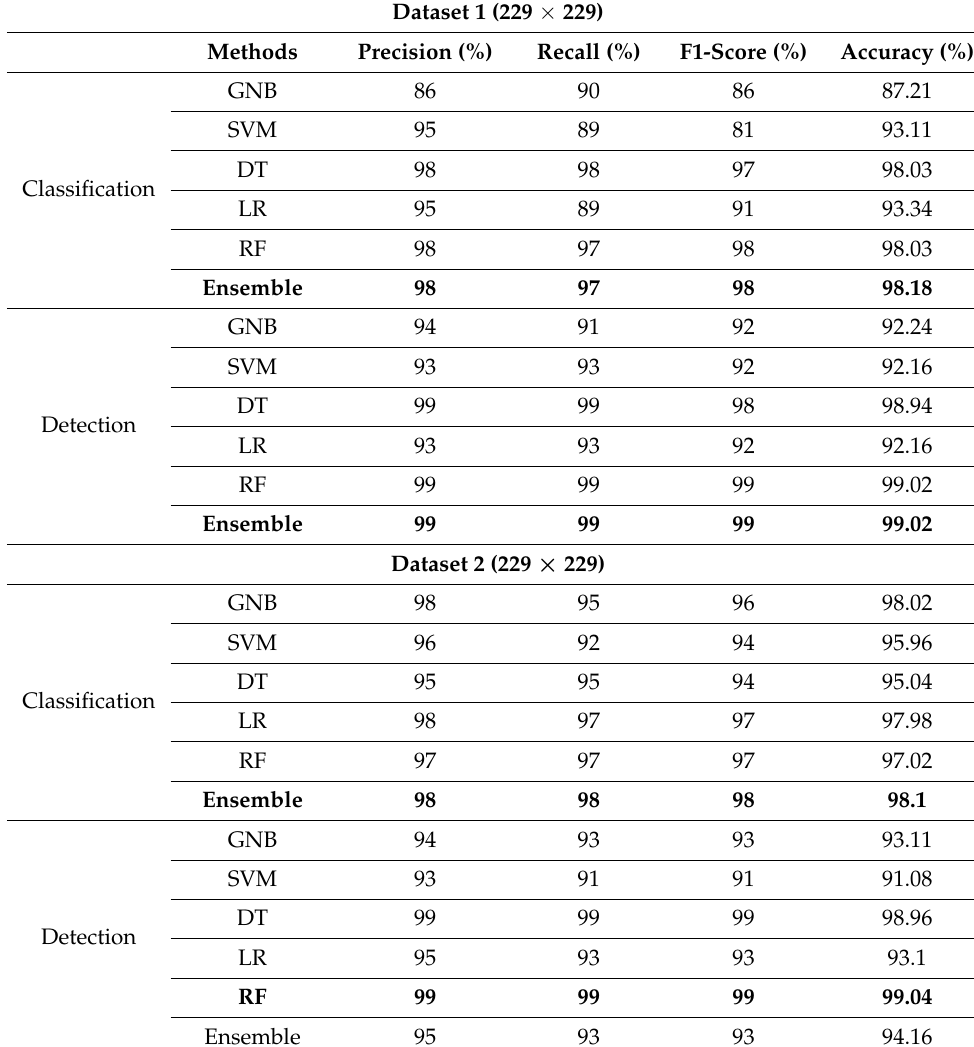
Table 4. Performance comparisons for malware classification and detection using both datasets with 229 ×